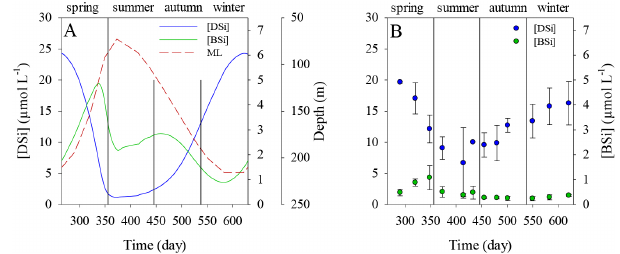
Fig. 5. Seasonal evolution of (A) modelled concentrations of dis- solved silicon (DSi) and biogenic silica (BSi) shown alongside the mixed layer depth (ML) of the model and (B) monthly averaged DSi and BSi from the KERFIX data set (Jeandel et al., 1998).